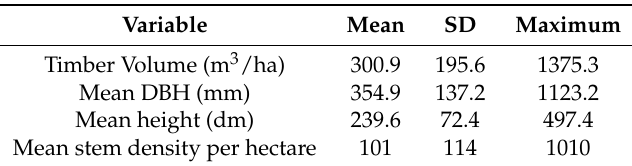
Table 1. Descriptive statistics of the forest observed on NFI sample plots located within communal and state forest area ( n 2 =